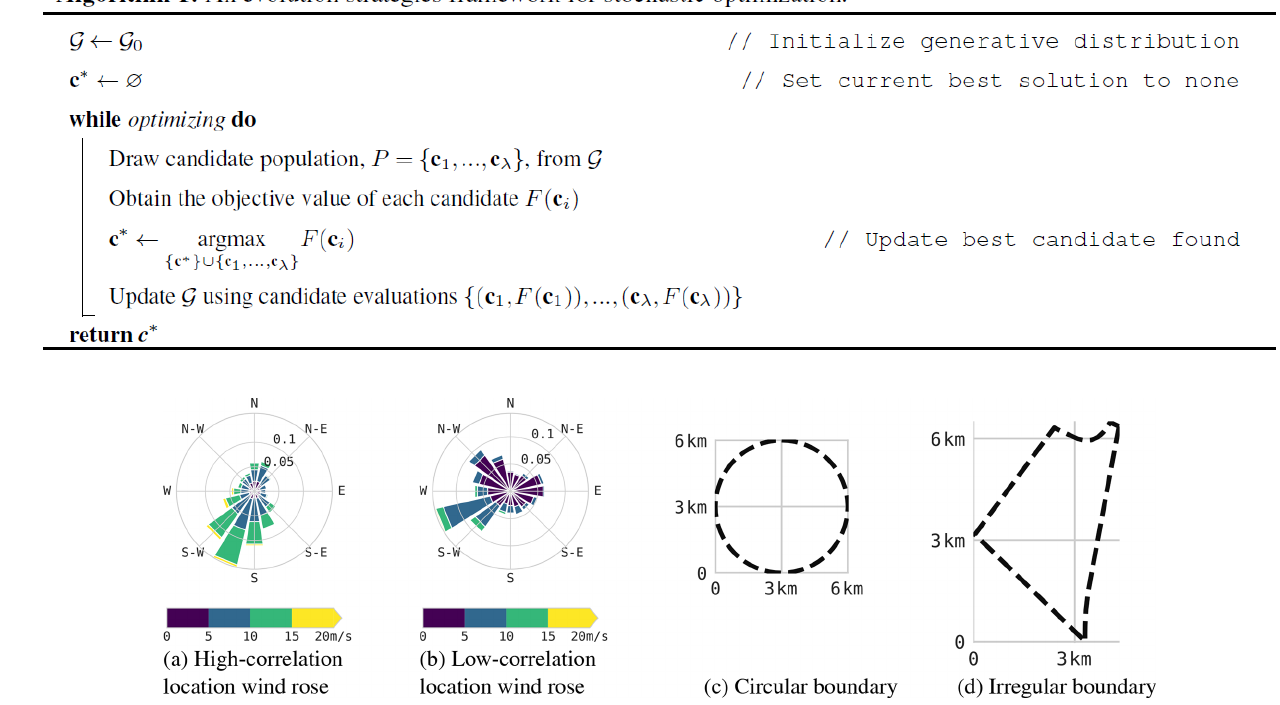
Figure 4. Wind roses and boundaries for the two locations and two boundaries used in our